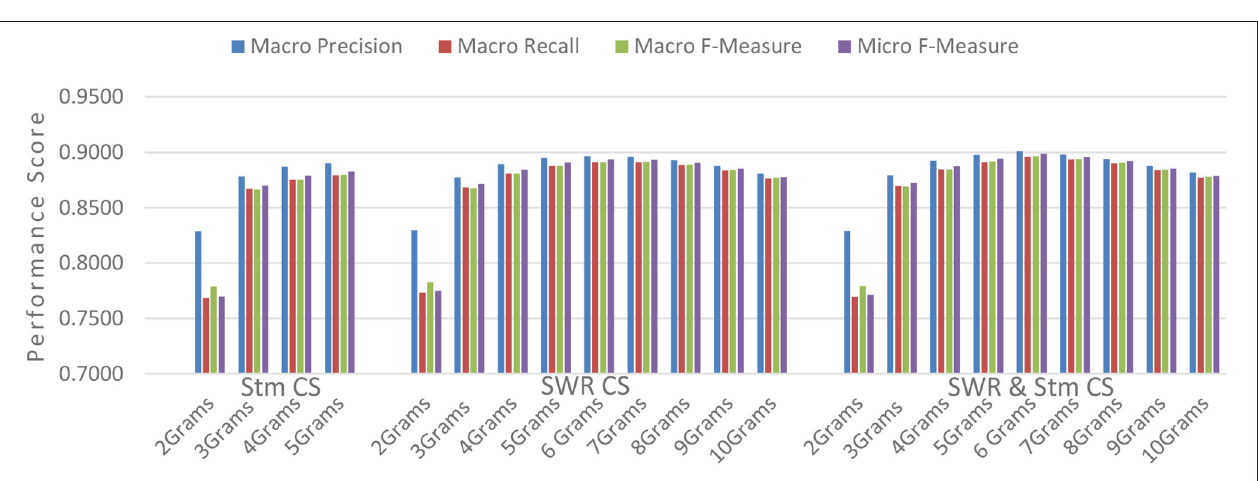
FIGURE 8 | Evaluating classifiers performance with 20Newsgroup.